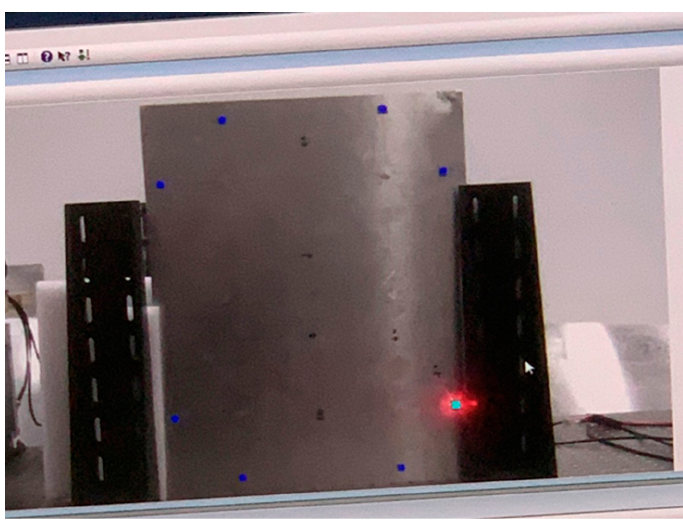
Figure 18. Scanning Laser Doppler Vibrometer scanning point location.